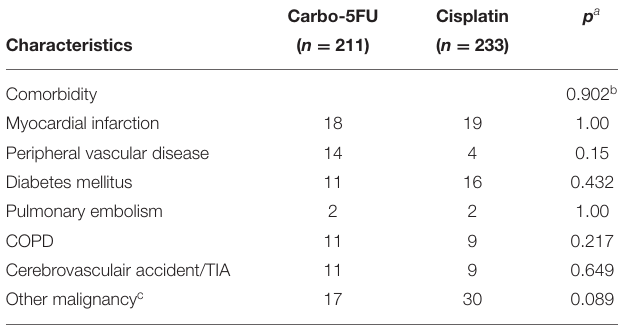
TABLE 1 | Baseline patient characteristics. TABLE 2 | Baseline comorbidity in the carbo-5FU and in the cisplatin cohort.